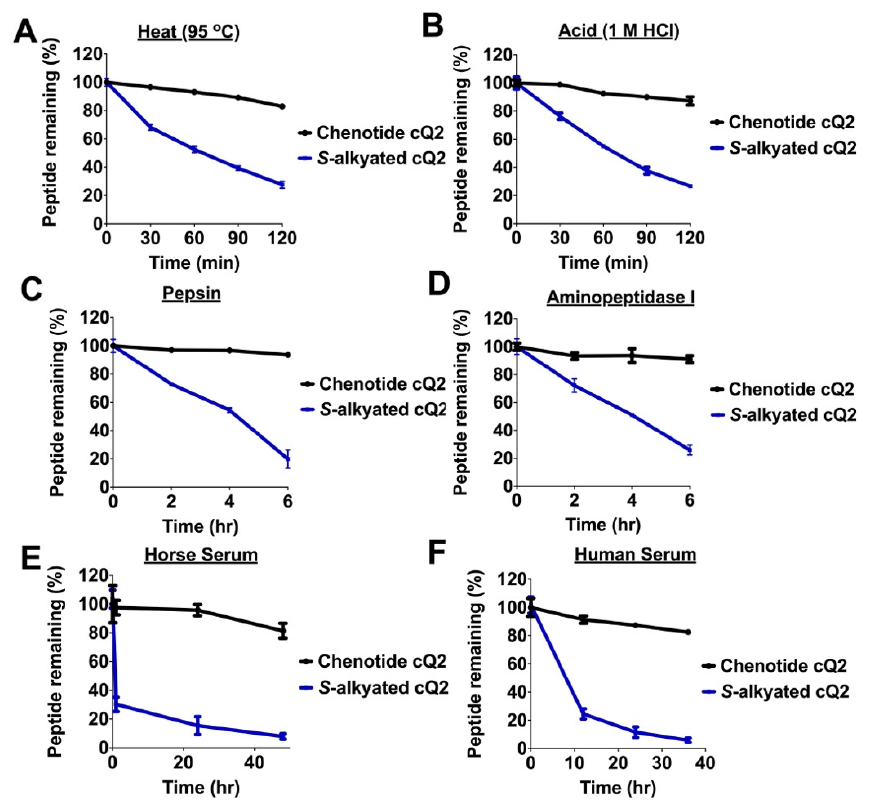
Figure 3. Chenotide cQ2 is hyperstable . Stability comparison of chenotide cQ2 and S -alkylated cQ2 (iodoacetamido-) under ( A ) heat (95 °C), ( B ) acid (1M HCl), ( C ) pepsin, ( D ) aminopeptidase I, ( E ) horse serum, and ( F ) human serum treatment as analyzed by RP-HPLC (n = 3).